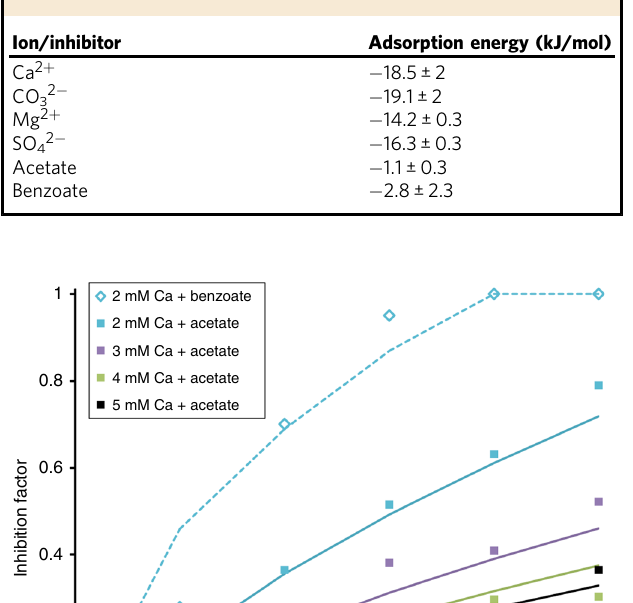
Table 1 Adsorption energies used in and obtained by the fi t to